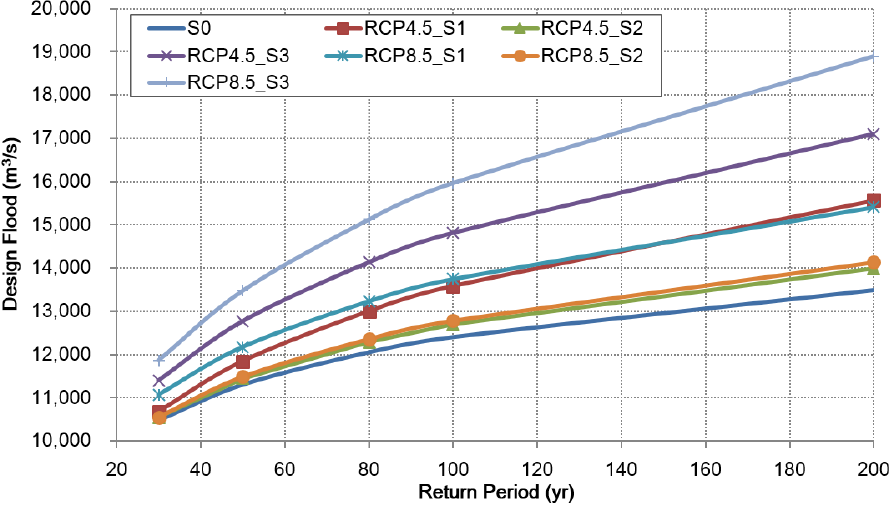
Figure 4. Estimated design floods for #2011.